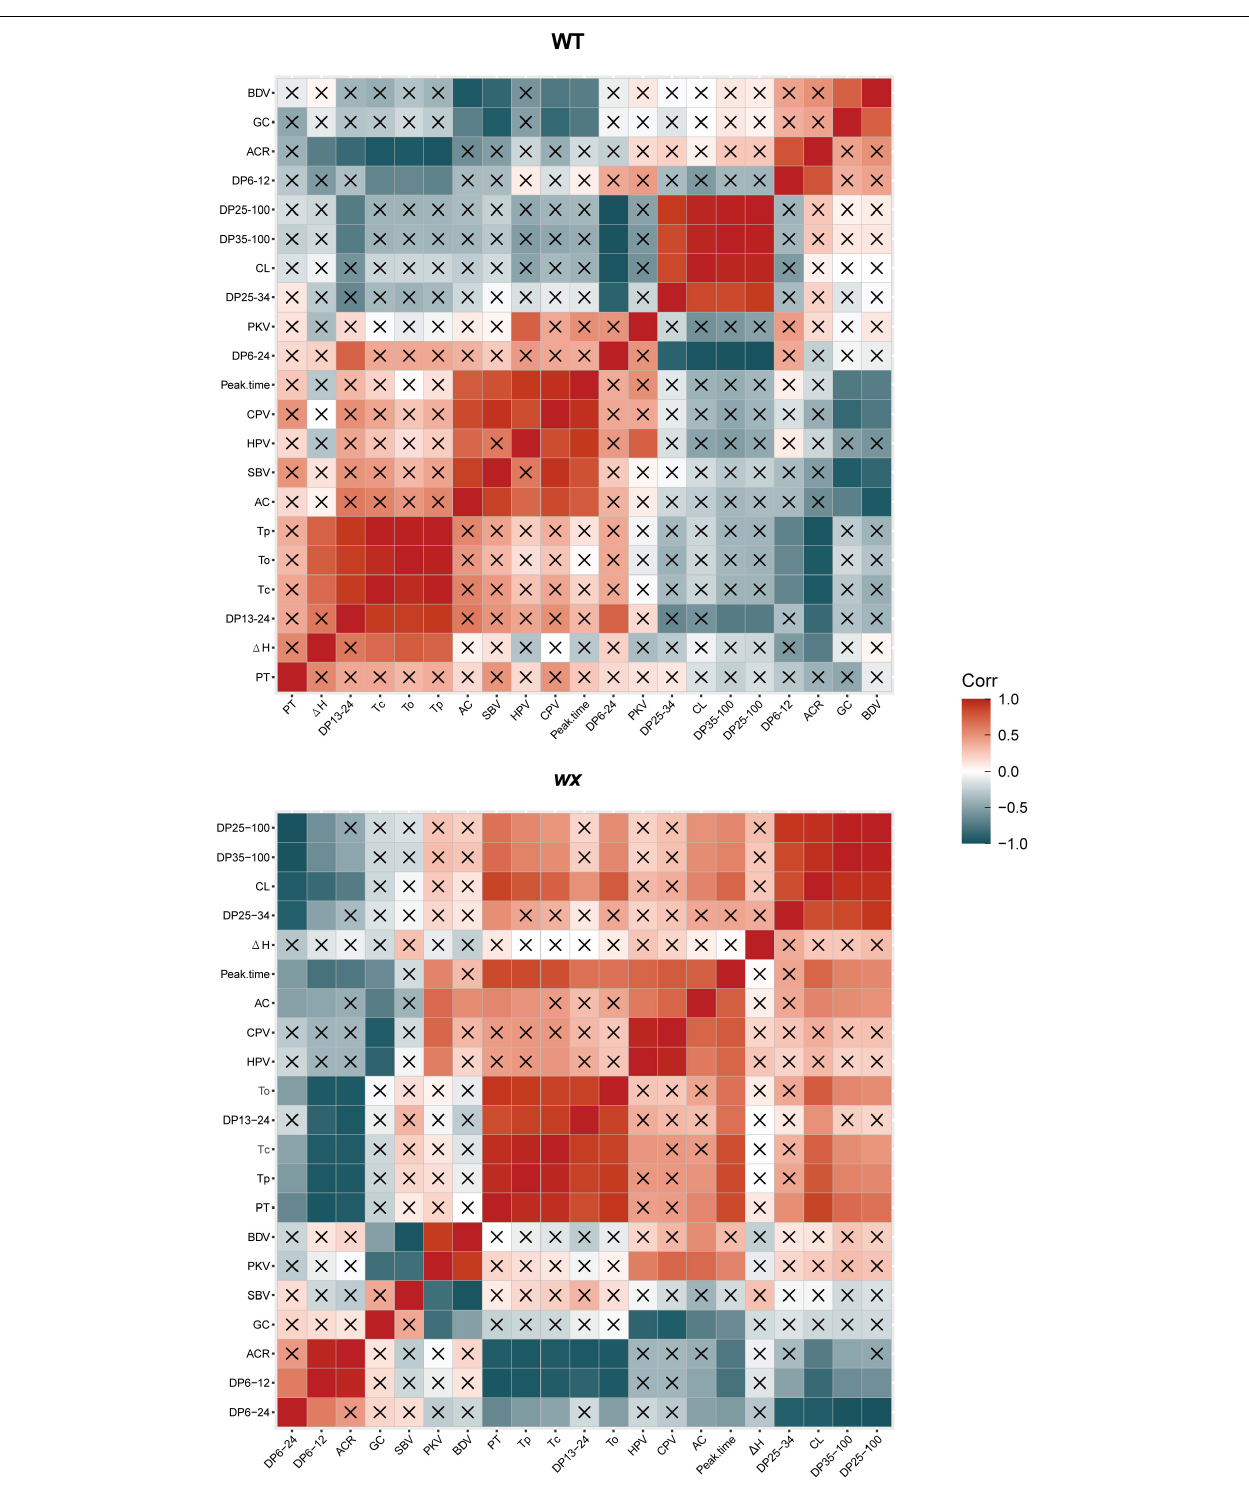
FIGURE 6 | Pearson’s correlation analysis of the relationship between amylopectin structure of wx mutants and their corresponding WTs. The stronger the red color, the more significant the positive correlation; the stronger the bluish-black color, the more significant the negative correlation. “ × ” means no correlation. (cid:49) H , gelatinization enthalpy; To , onset temperature; Tp , peak temperature; Tc , conclusion temperature; AC, amylose content; PKV, peak viscosity; HPV, hot paste viscosity; CPV, cool paste viscosity; BDV, breakdown viscosity; SBV, setback viscosity; PT, pasting temperature; ACR value, amylopectin chain ratio; CL, chain length; GC, gel